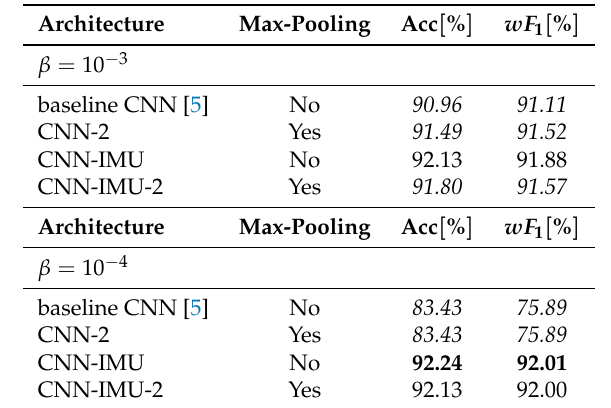
Table 3. Validation accuracies and Weighted F1 for architectures with and without max-pooling operations on the Opportunity-Gestures dataset. CNN & CNN-2 architectures with β = 10 − 4 overfit to the “Null” class with zero predictions for the other action